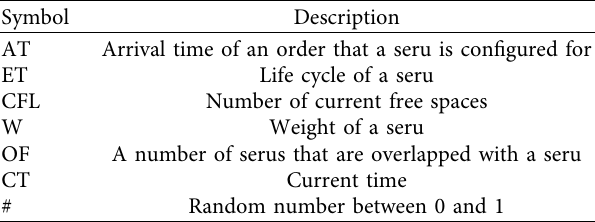
Table 1: Terminals for the SSRC